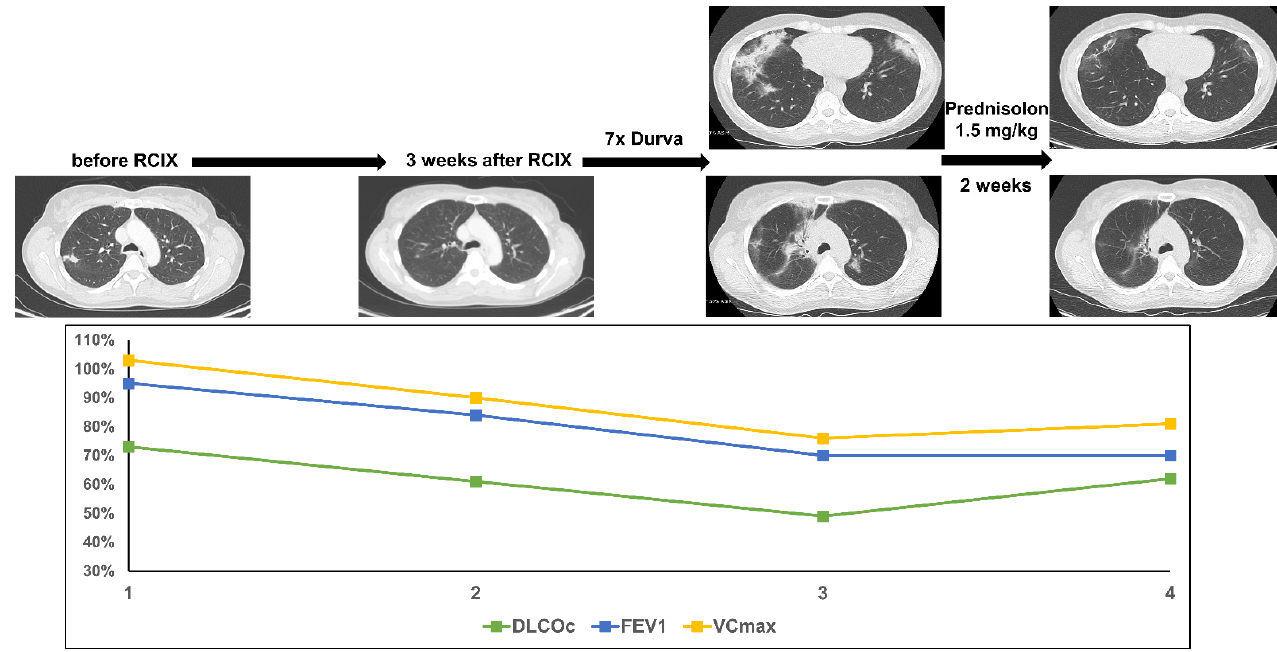
Figure 1. The figure shows course of treatment, corresponding CT imaging and lung function values of patient 1. (RCIX: Radiochemoimmunotherapy; Durva: Durvalumab).